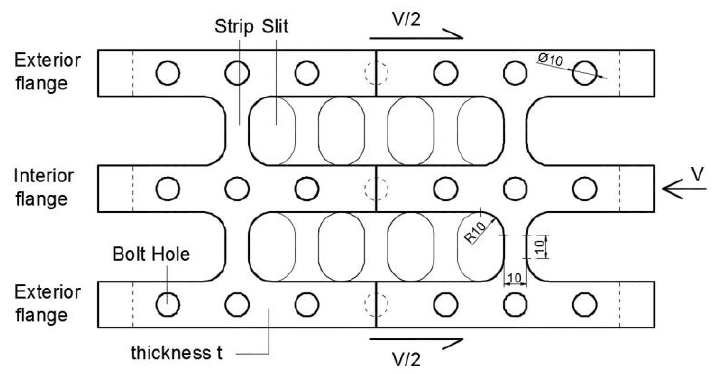
Figure 2. Hysteretic damper (steel plate with slits).